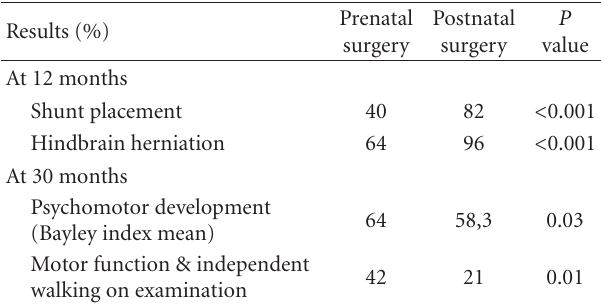
Table 2: MOM study results, January 2011